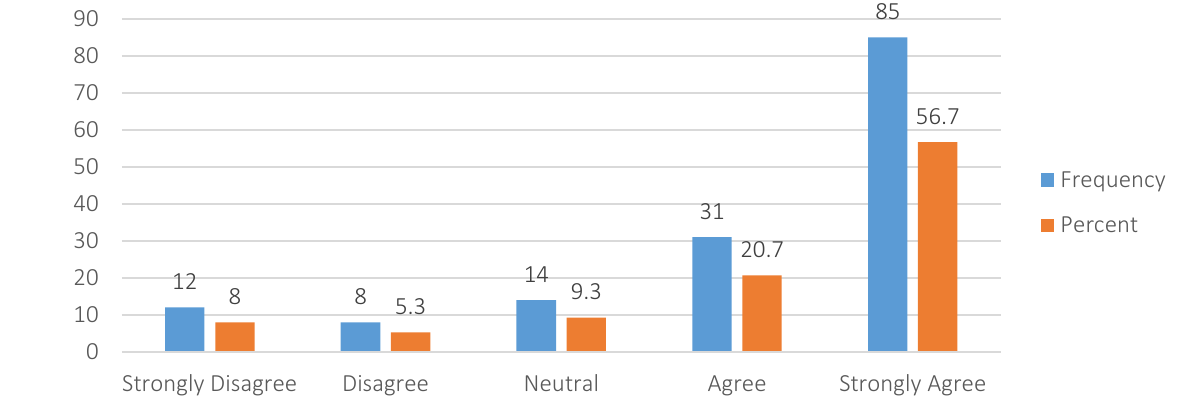
Figure 9. The adoption of relevant MAPs influences business operations